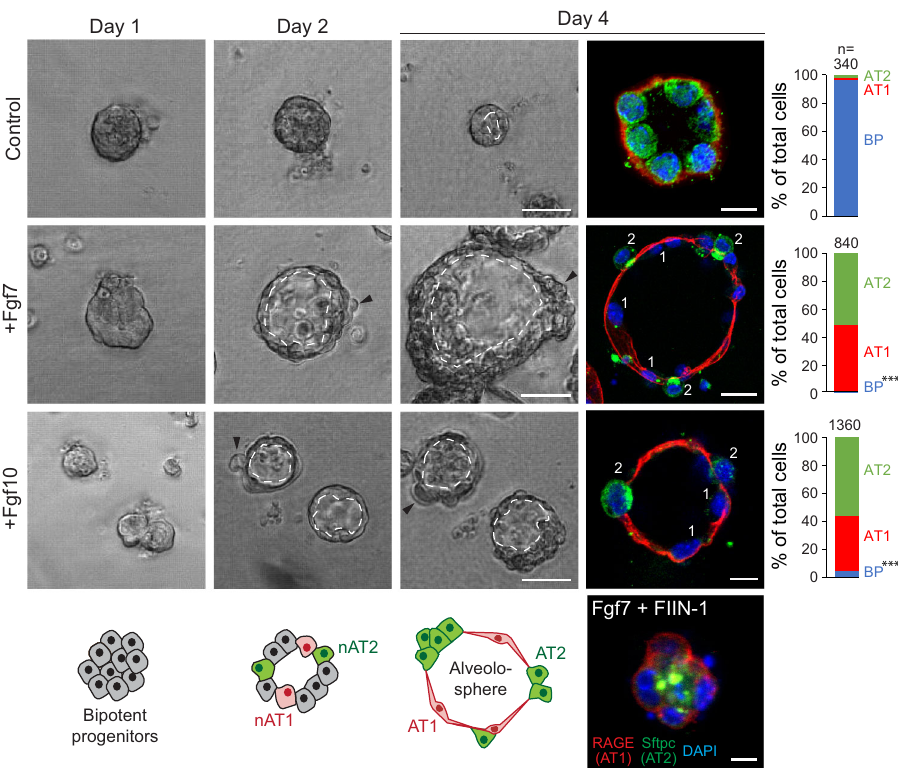
Fig. 2 | Effect of Fgfr2 ligands on puri fi ed alveolar epithelial progenitors in culture. Phase images (left panels) and immunostains (right) of epithelial pro- genitors puri fi ed from tips of e16.5 lungs and cultured in Matrigel for the period indicatedwithmediaalone(Control,toppanels)ormediasupplementedeverytwo days with Fgf7 (50ng/ml, middle panels) or Fgf10 (100ng/ml) and HSPG (100ng/ ml,lowerpanels).Note anincrease inluminal surface area(dashed lines) andbasal extrusion (arrowheads) in cultures with Fgf ligands, and differentiation into inter- mingledcuboidalAT2(Sftpc pos ,green)andsquamousAT1cells(RAGE pos ,red)atday 4( “ alveolospheres ” ).IncontrolcultureslackingFGFs(toprow)ortreatedbothwith Fgf7 and the Fgfr inhibitor FIIN-1 (bottom panel), cells remained bipotent